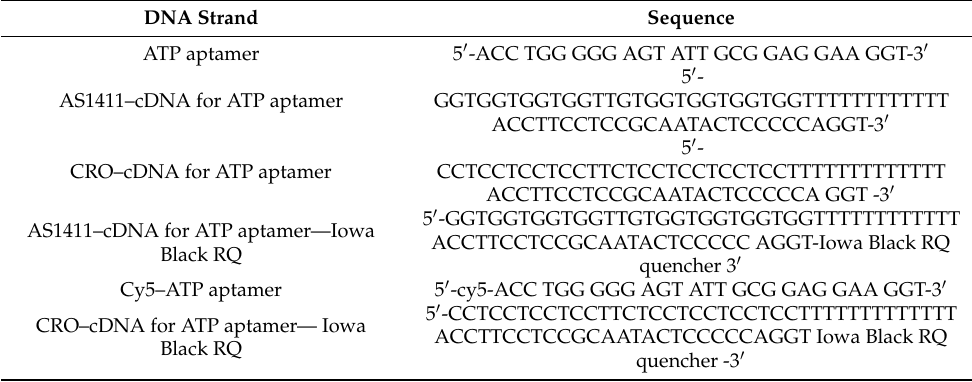
Table 1. Nucleic acid sequences.